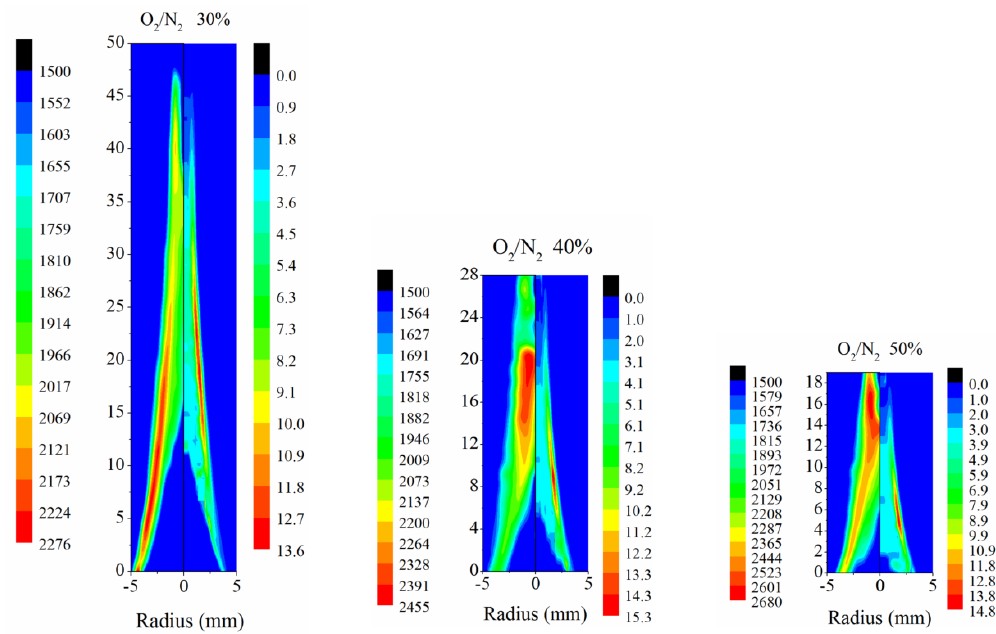
Figure 16. 2-D distributions of temperature T (K) and soot volume fraction (10 − 6 ) for C 2 H 4 combustion in O 2 /N 2 oxygen-enhanced atmospheres.